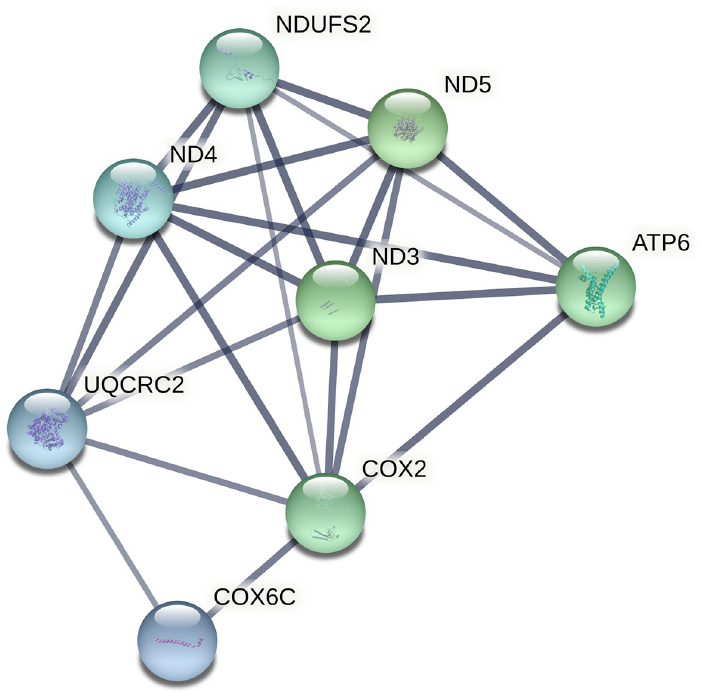
Fig 1. Clustering of mitochondrial DEGs related to electron transport and oxydative phosphorilation obtained with the Search Tool for the Retrieval of Interacting Genes/Proteins (STRING) software. Line thickness indicates the strenght of data